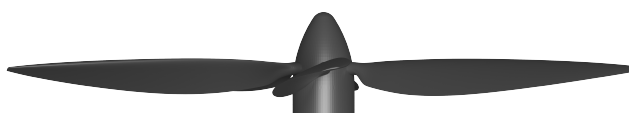
Figure 7. Side view of the blade angle under hovering conditions.